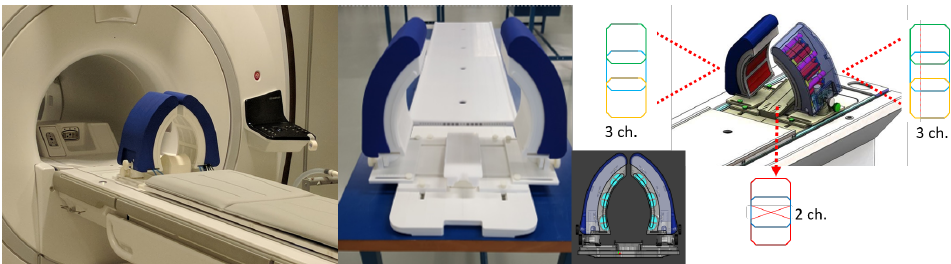
Figure 1. Picture of MRcollar applicator prototype without the inner water bolus and the location of the integrated MR receiver